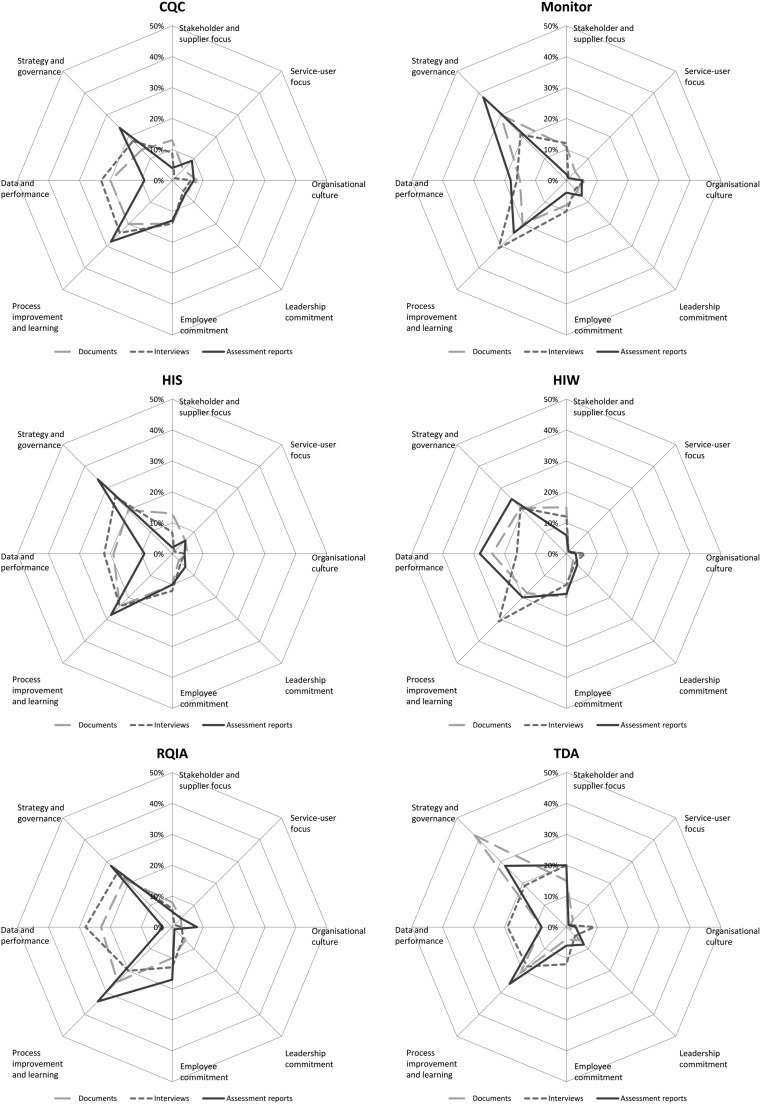
Content analysis.